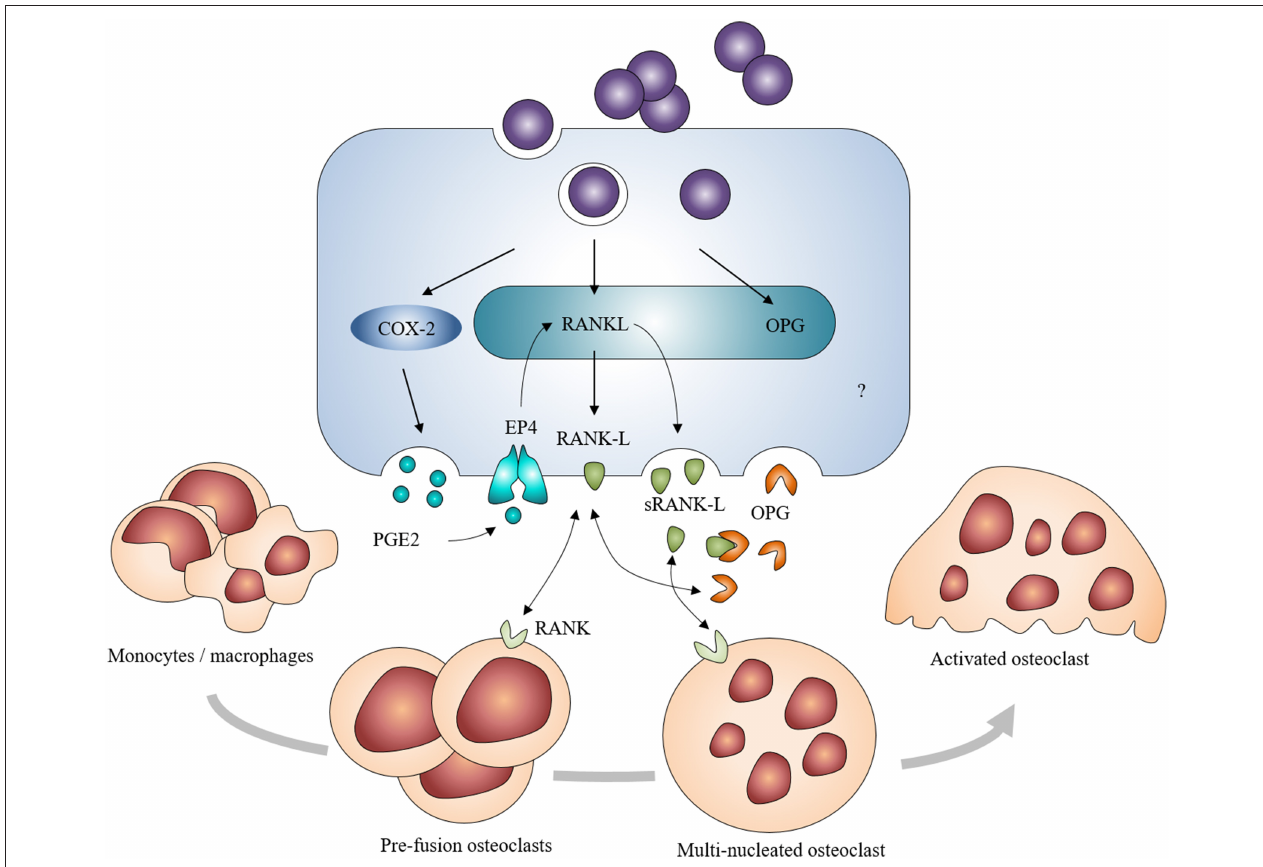
FIGURE 5 | Induction of osteoclastogenesis by Staphylococcus aureus -challenged osteoblasts. S. aureus -challenged osteoblasts increase their expression and production of RANK-L, directly or through the COX-2/PGE2 pathway. It leads to an excessive formation and activation of osteoclasts and to a severe bone resorption in addition to a decreased production of